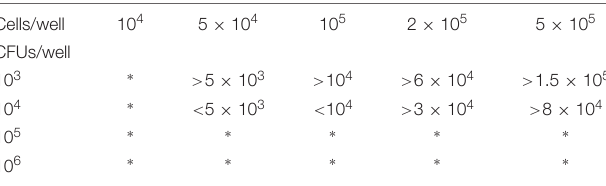
The results in table represented the live cells after co-culturing, ∗ no cells were